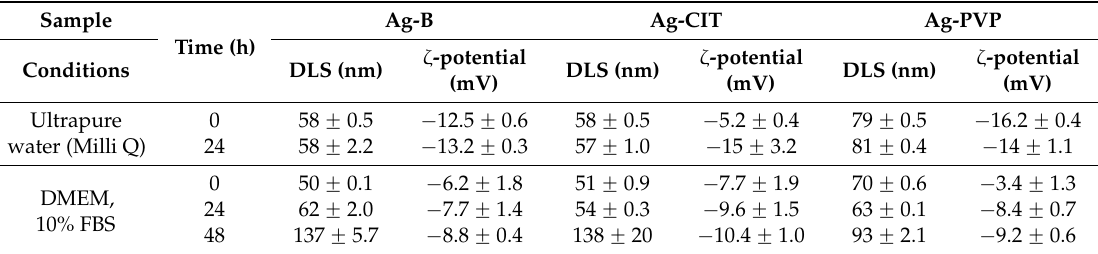
Table 1. Summary of average hydrodynamic size and ζ -potential of three Ag NPs in water and full cell culture medium. Ag NPs suspended in medium were kept in the incubator (37 °C, 95% air/5% CO 2 ) and the pH value of medium kept around 7.4 during the whole incubation process. All data are represented as the mean ± SD ( n = 3).